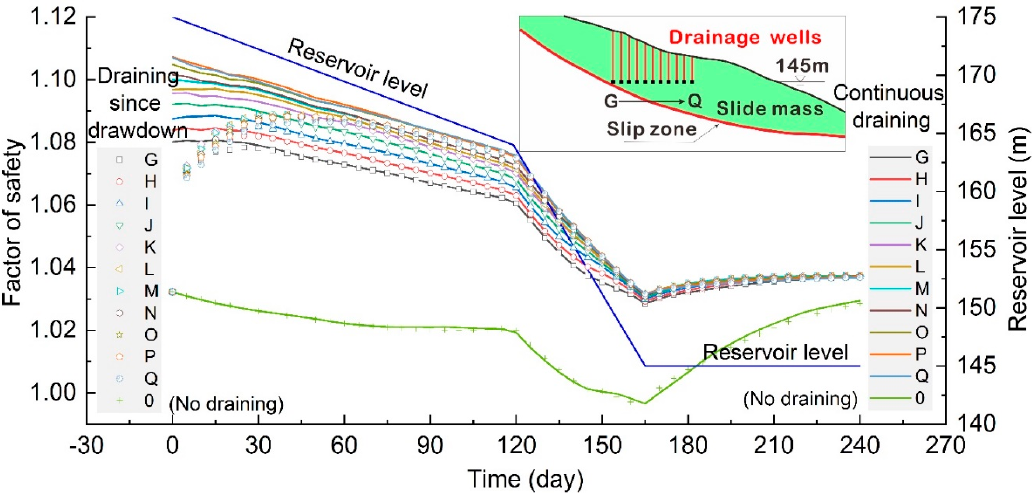
Figure 11. Comparison of the draining effect of different drainage modes on landslide treatment result.